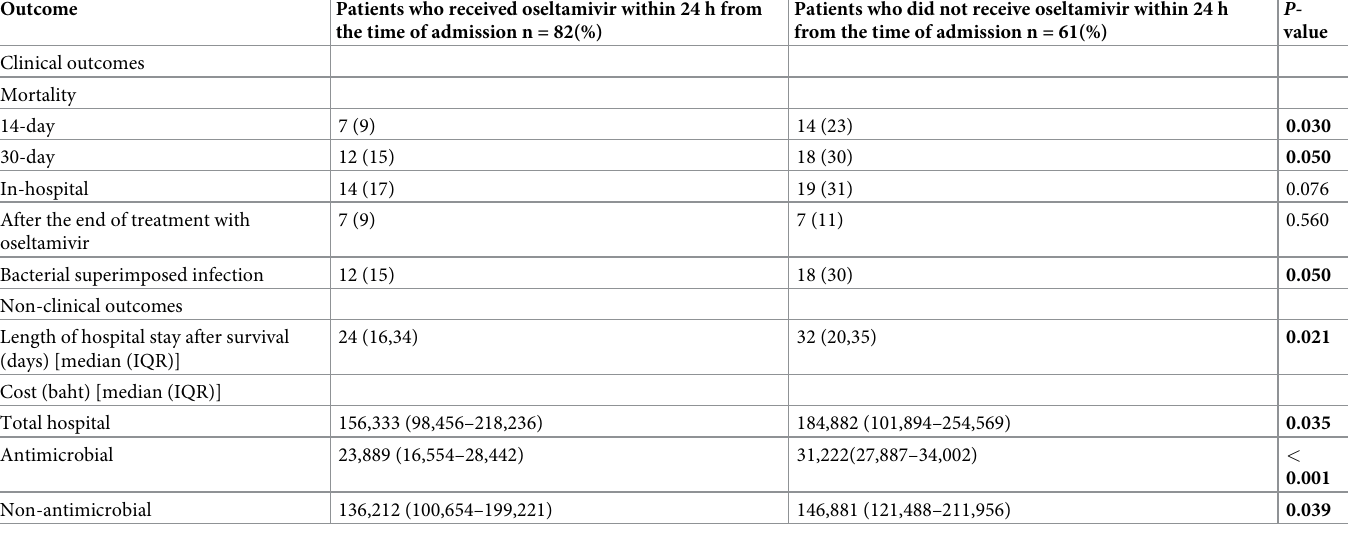
Table 2. Comparison of outcomes between patients with community-acquired influenza pneumonia who received oseltamivir within 24 h from the time of admis- sion and those that received later than 24 h. Outcome